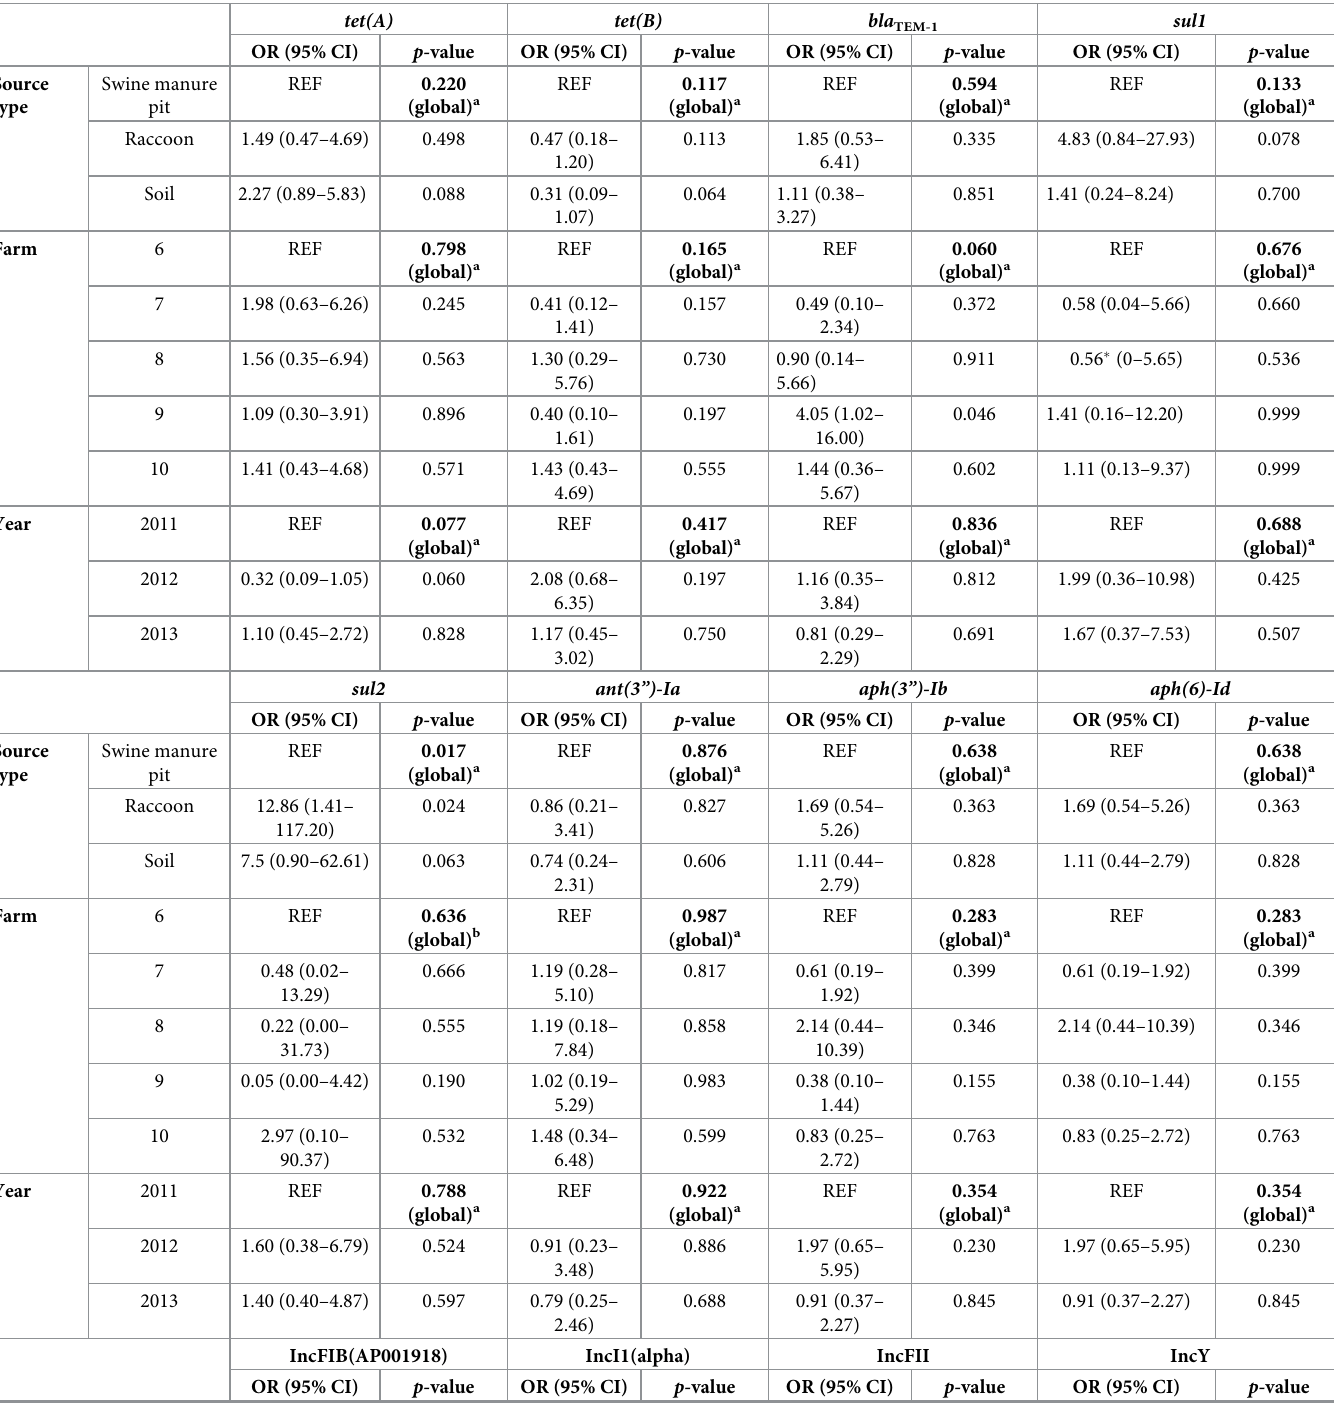
Table 7. Univariable logistic regression models a,b,c assessing the association between source type, farm location, and year of sampling, and the occurrence of select antimicrobial resistance genes and plasmid incompatibility (Inc) types in phenotypically resistant Escherichia coli isolates obtained from raccoons, swine manure pits, and soil samples on swine farms in southern Ontario, Canada 2011–2013 (n =